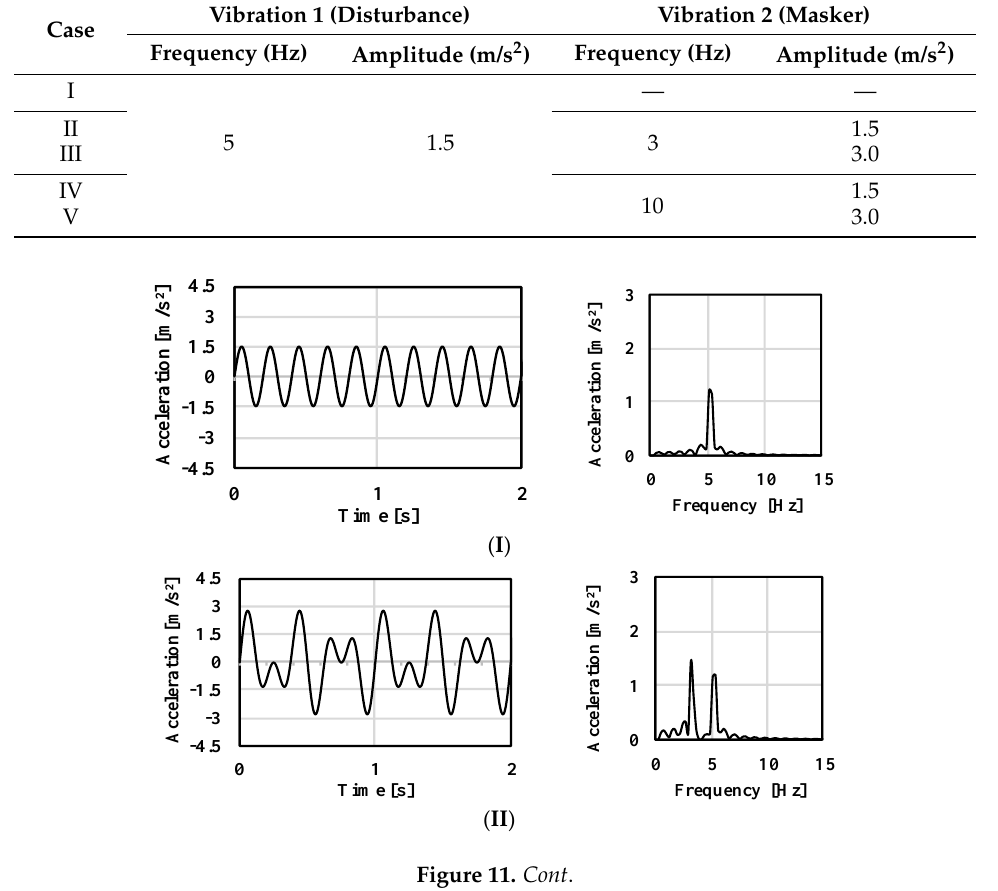
Table 1. Vibration conditions in experiments.